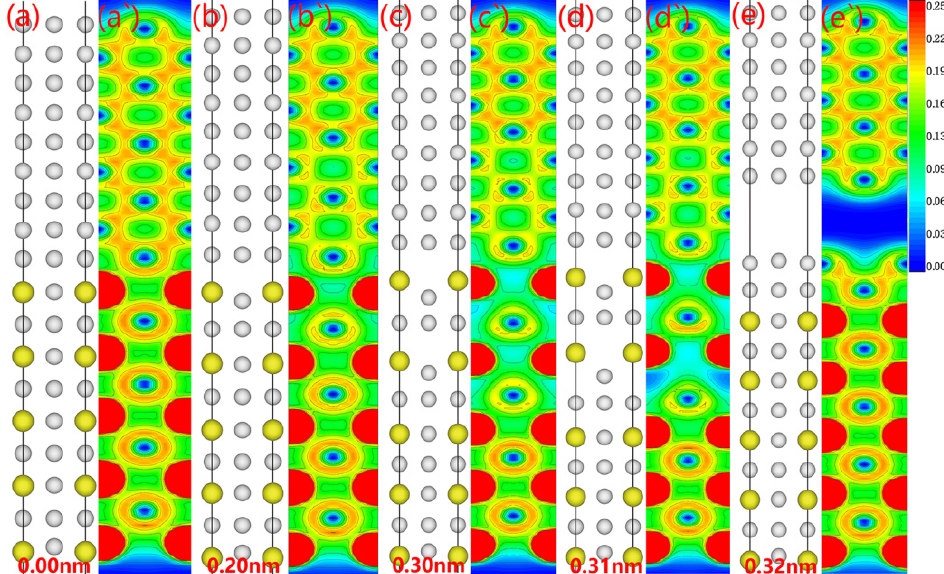
Figure 9. Fracture behavior and corresponding electron density of stretched Al 3 Y(010)|Al(010) system: ( a – e ) atomic site of the interface system, ( a` – e` ) electron density of the